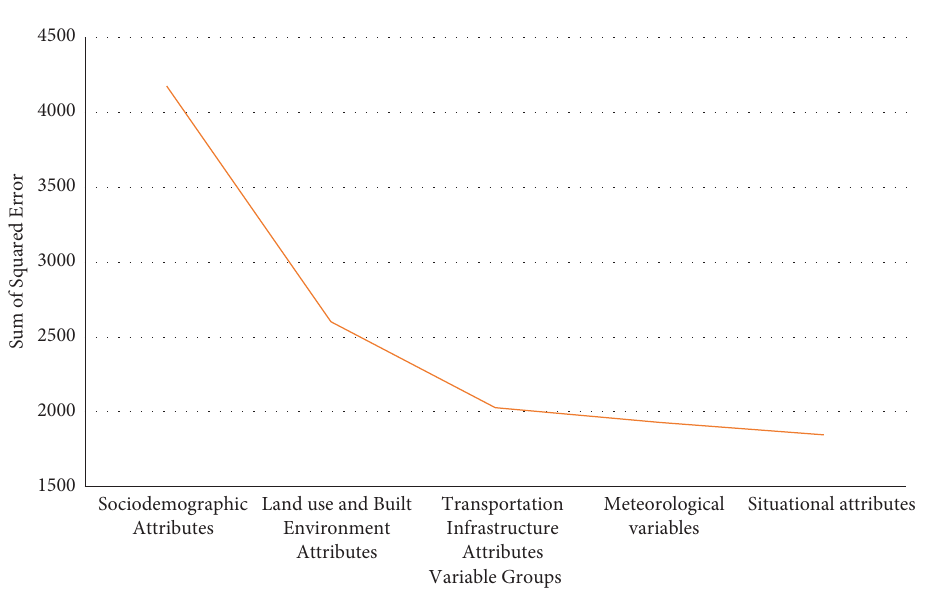
Figure 6: Sum of squared error for weekday evening